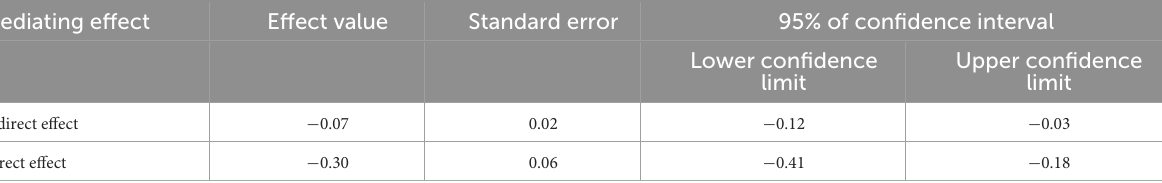
TABLE 4 Bootstrap test for mediating